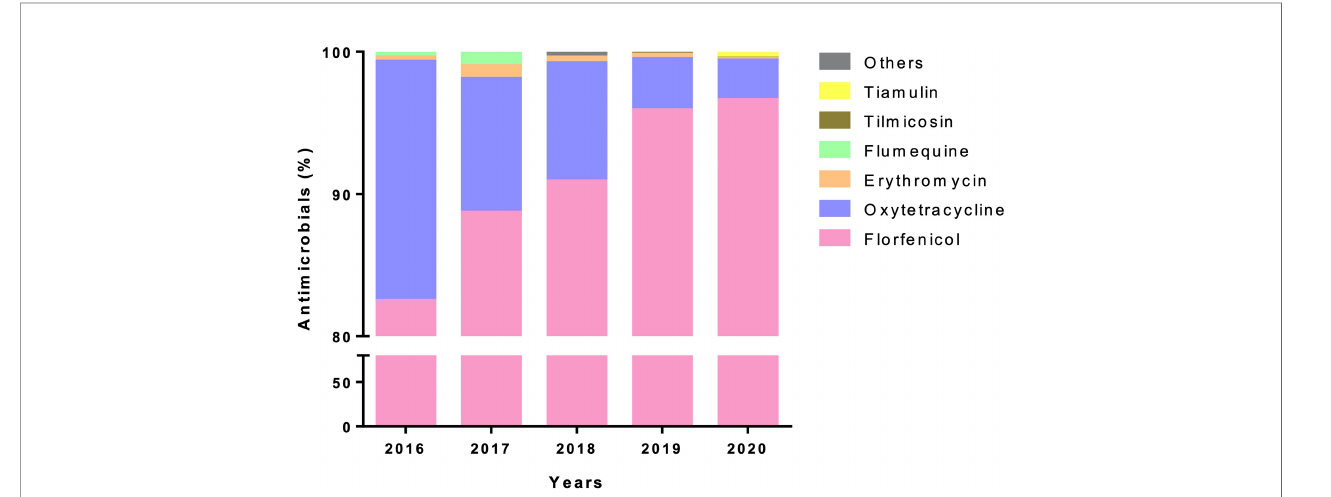
FIGURE 6 | Use of antimicrobial by aquaculture industry in Los Lagos Region. Percentage of diverse antimicrobials (y-axis) used in Los Lagos Region during 2016-